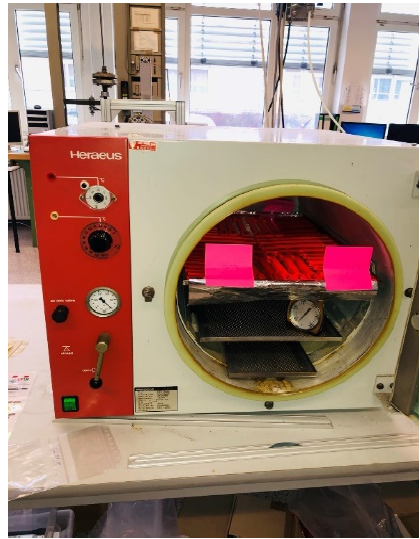
Figure 11. Oven at 60 °C and air pressure at 0 bar.